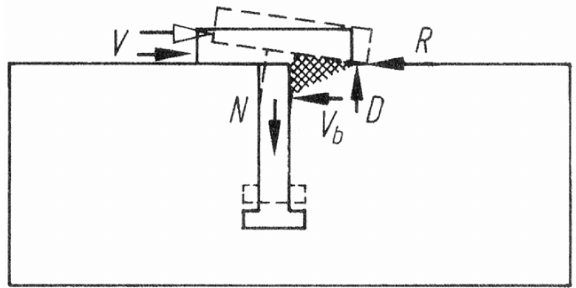
Figure 5. Stress distribution in uncracked concrete.